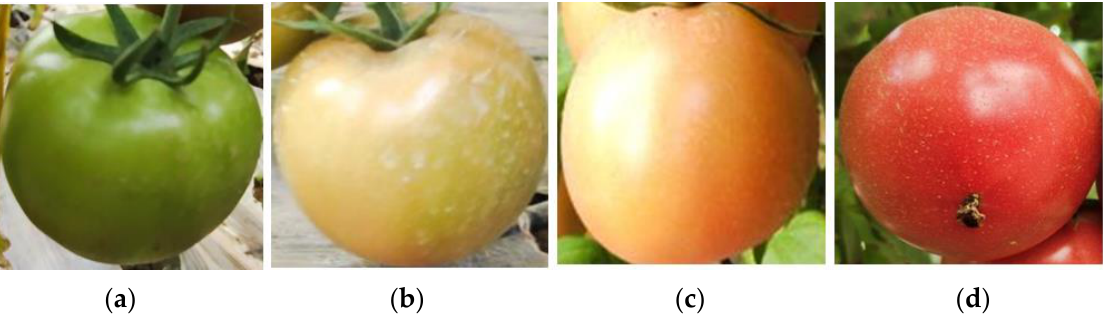
Figure 2. Images of four different ripening tomatoes. ( a ) <60%; ( b ) 61%_70%; ( c ) 71%_80%; ( d ) 81%_100%.